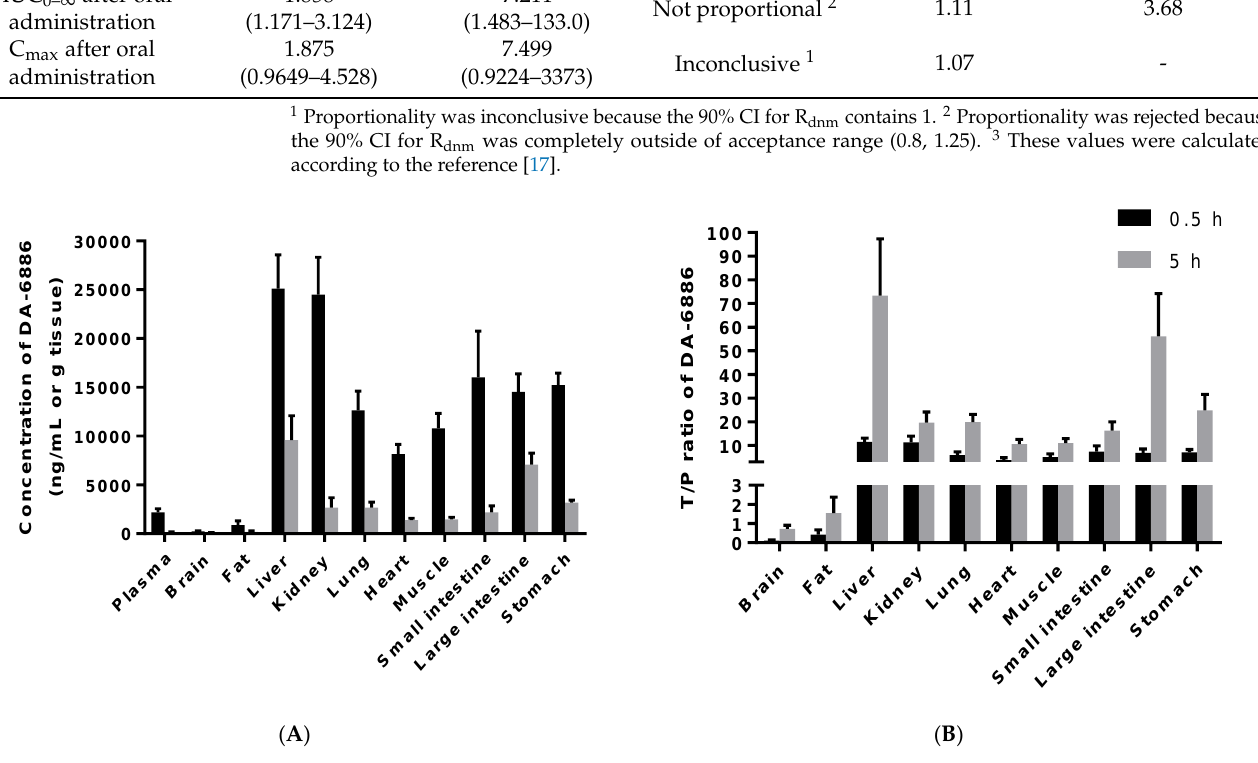
Figure 3. Tissue concentration ( A ) and T/P (Tissue (ng/g tissue) to plasma (ng/mL)) ratio ( B ) of DA-6886 at 0.5 h (black bar, n = 5) and 5 h (gray bar, n = 5) after single intravenous administration of DA-6886 hydrochloride at a dose of 10 mg/kg to male Sprague-Dawley rats. Data are expressed as mean ± S.D.